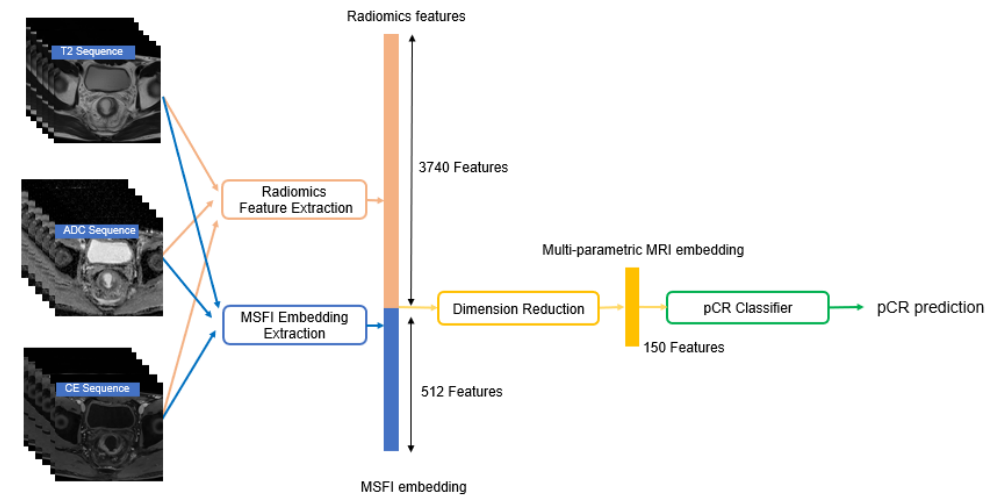
Figure 5. The overall pCR prediction method using both radiomics features and MSFI embedding, given three MRI